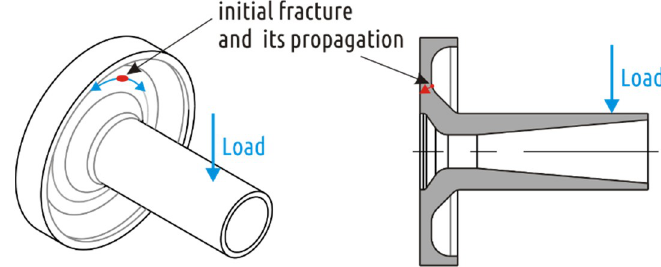
Figure 13. The initial rupture position on Shape 4 samples and the direction of crack propagation.